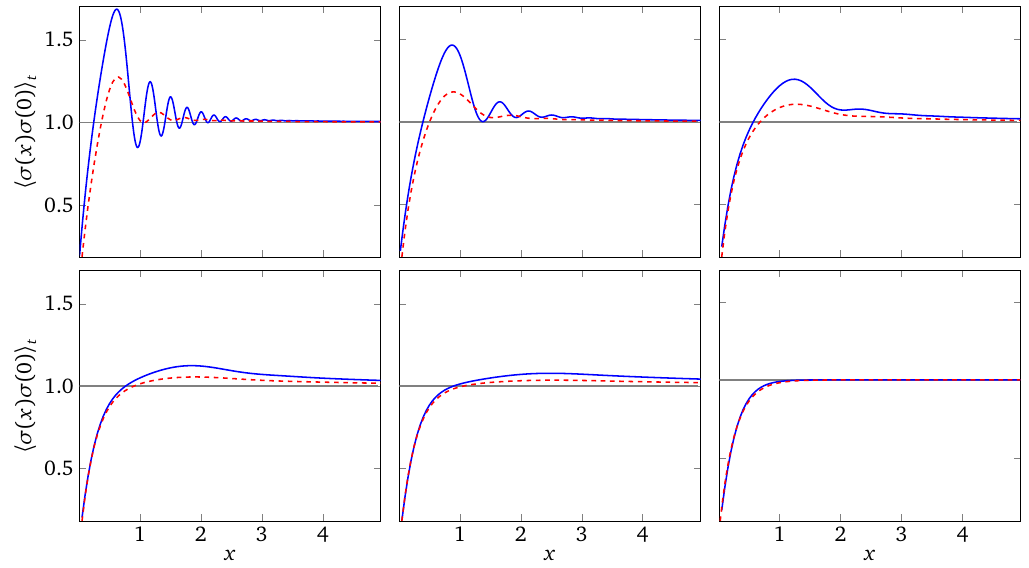
Figure 4: Two-point function 〈 σ ( x ) σ ( 0 ) 〉 (red) and c = 10 (blue), for different values of t = 0.025,0.05,0.1,0.2,0.3, ∞ (in reading